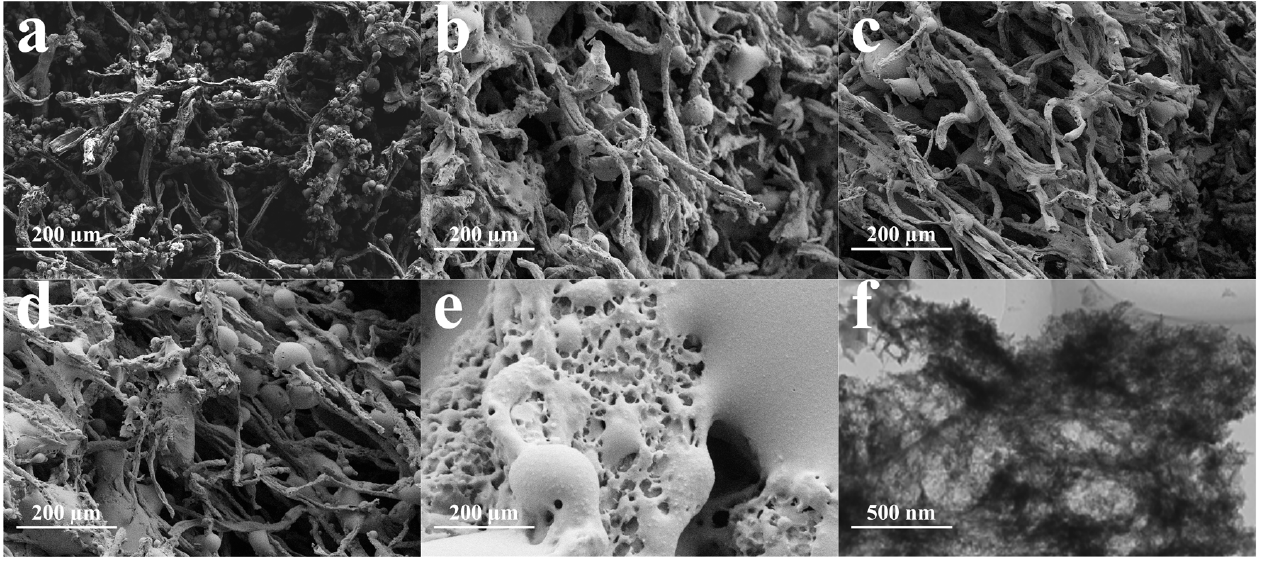
Figure 4. SEM image of ( a ) 10 wt% ZMOCN, ( b ) 30 wt% ZMOCN, ( c ) 50 wt% ZMOCN, ( d ) 70 wt% ZMOCN ( e ) 90 wt% ZMOCN, and ( f ) TEM image of 50 wt% ZMOCN.